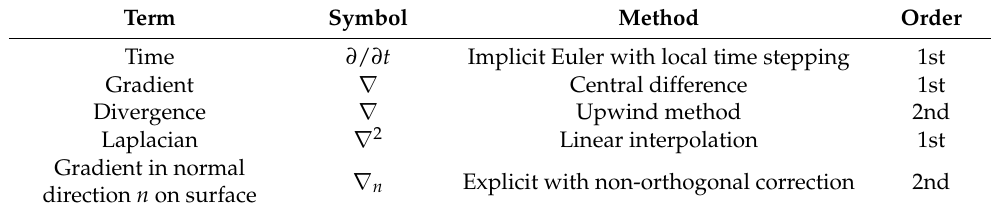
Table 2. Numerical